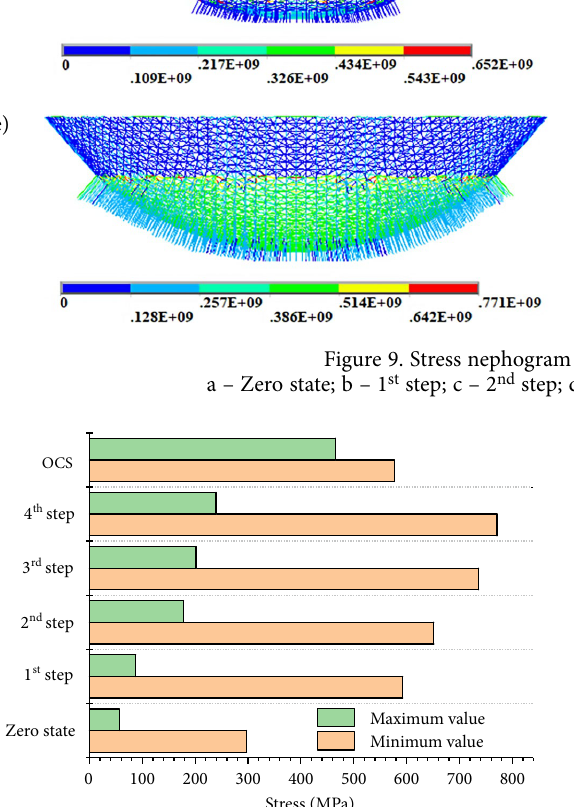
Figure 10. Stress extremum for different tensioning stages